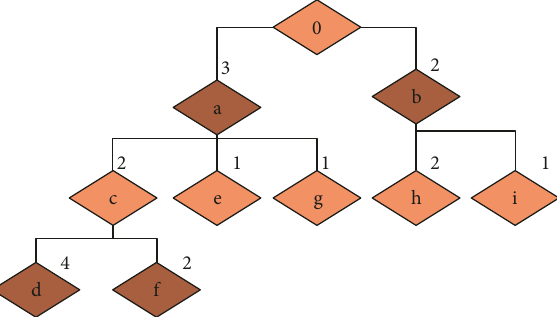
Figure 1: English teaching information